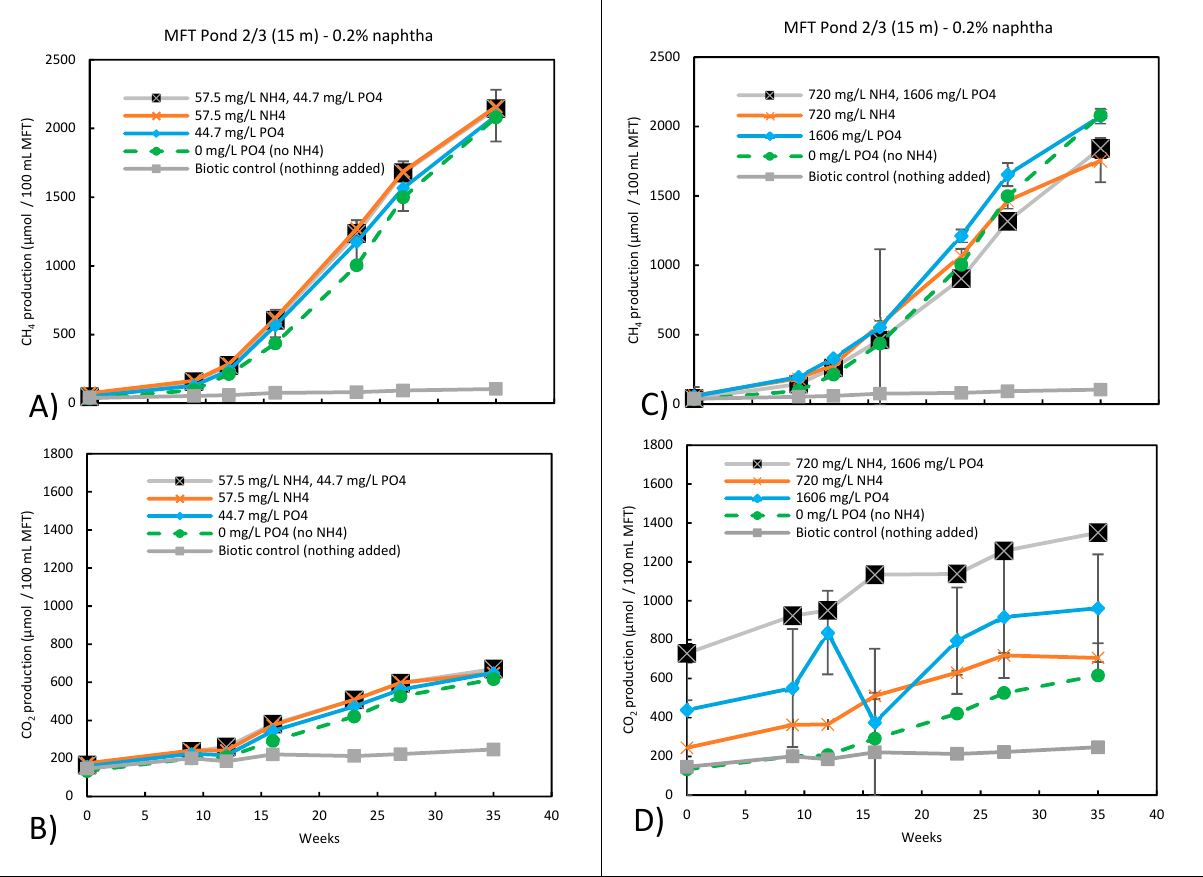
Figure 2. ( A ) CH 4 and ( B ) CO 2 production of duplicate microcosms for MFT from Pond 2/3 at 15 m amended with 0.2% naphtha and low concentrations of NH 4+ and/or PO 43 − . ( C ) CH 4 and ( D ) CO 2 production of duplicate microcosms for MFT from Pond 2/3 at 15 m amended with 0.2% naphtha and high concentrations of NH 4+ and/or PO 43 − . After naphtha addition, microcosms were mixed for 30–60 min on a rotary shaker then incubated in the dark. Error bars have been inserted, and where not visible, the error was too small to be seen.